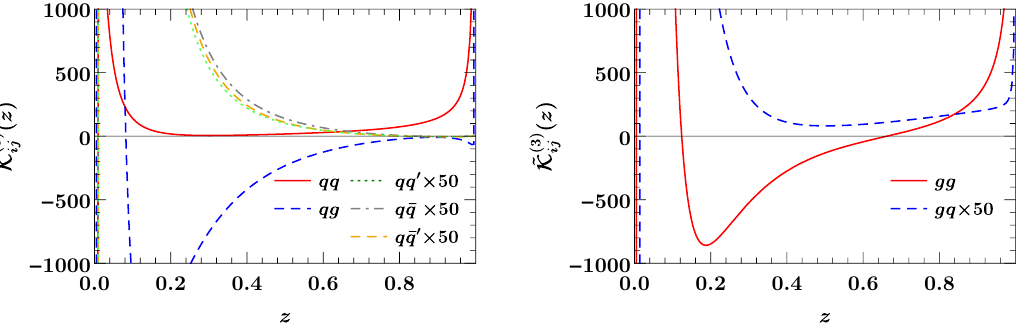
Figure 3 . The N 3 LO TMD fragmentation function boundary term ˜ K (3) matching kernels in all channels entering the quark fragmentation (left) and the gluon fragmentation (right) are displayed. For illustration purposes the kernels have been rescaled as